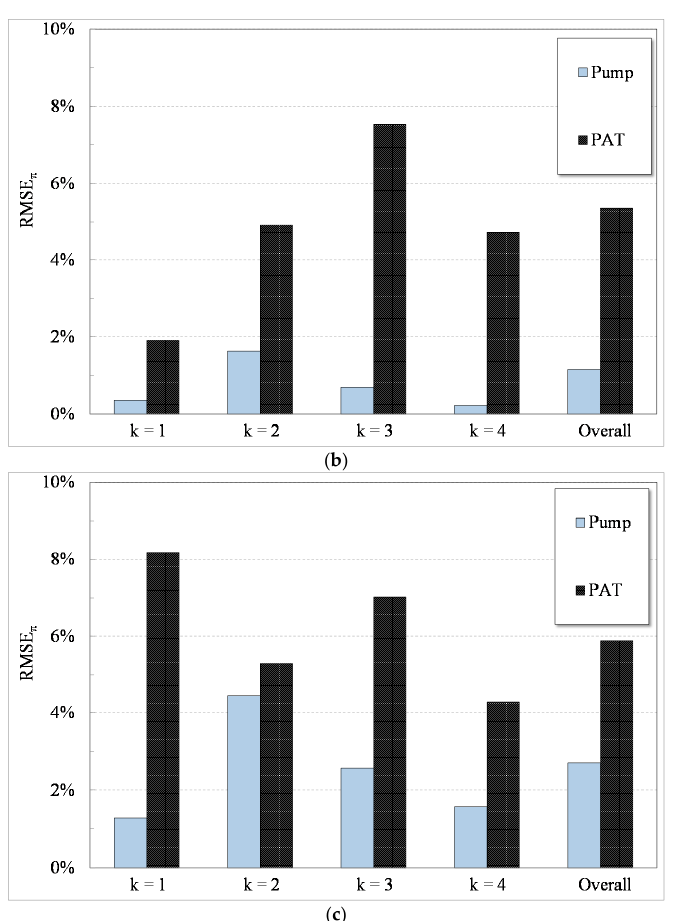
Figure 2. RMSE Yk values for ( a ) non-dimensional head; ( b ) non-dimensional power and ( c ) efficiency.